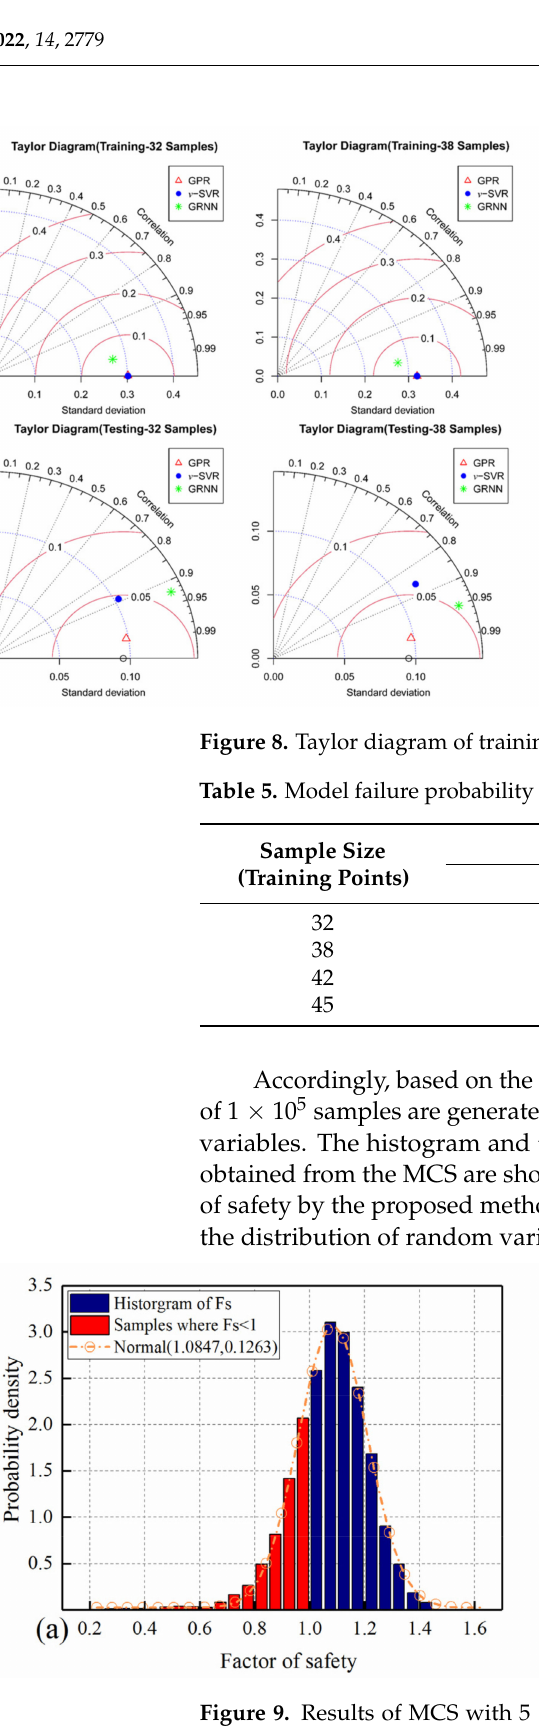
Figure 9. Results of MCS with 5 × 10 4 samples for Case 1: ( a ) Histogram and normal fit for the obtained factor of safety with a normal distribution of random variables; ( b ) probability density distribution for the obtained factor of